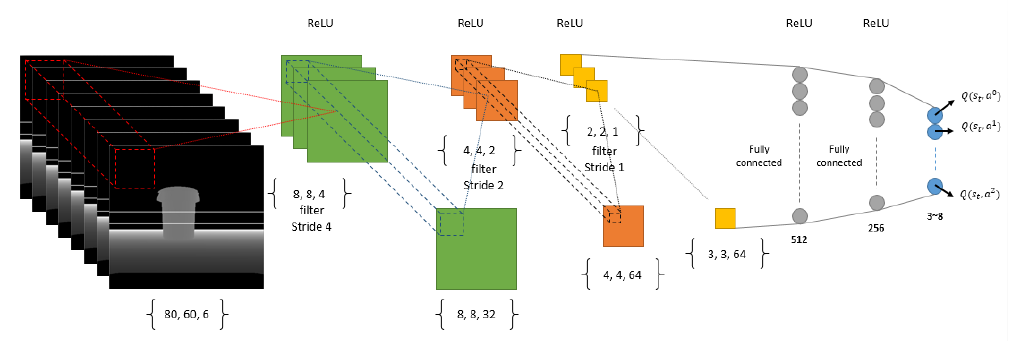
Figure 4. The deep learning architecture used as a function approximator in our deep reinforcement learning regarding discrete-action type by changing the DQN ([12]) architecture slightly to suit our input and short-term memory structure.